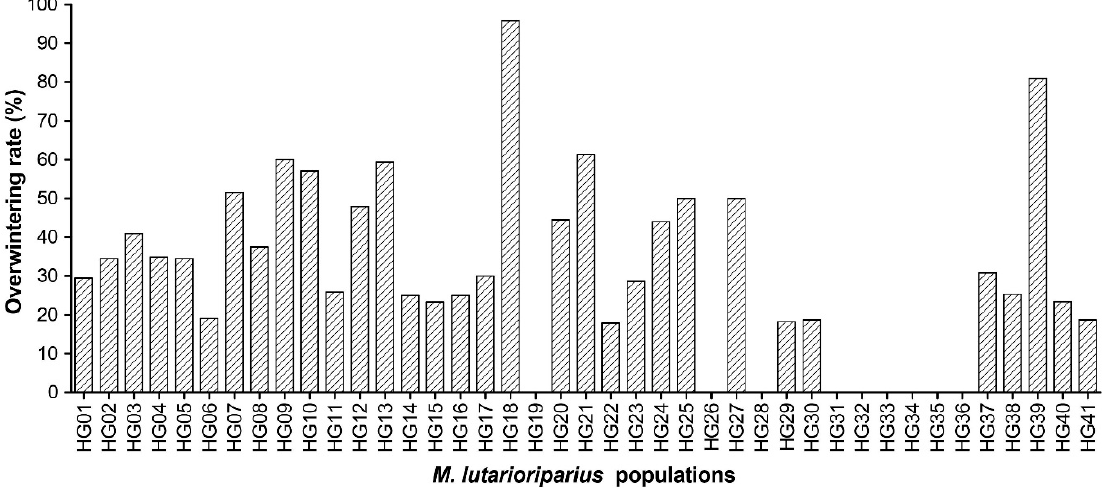
Figure 2. Overwintering rate of 41 M. lutarioriparius populations based on surviving individuals in 2012 and 2013.